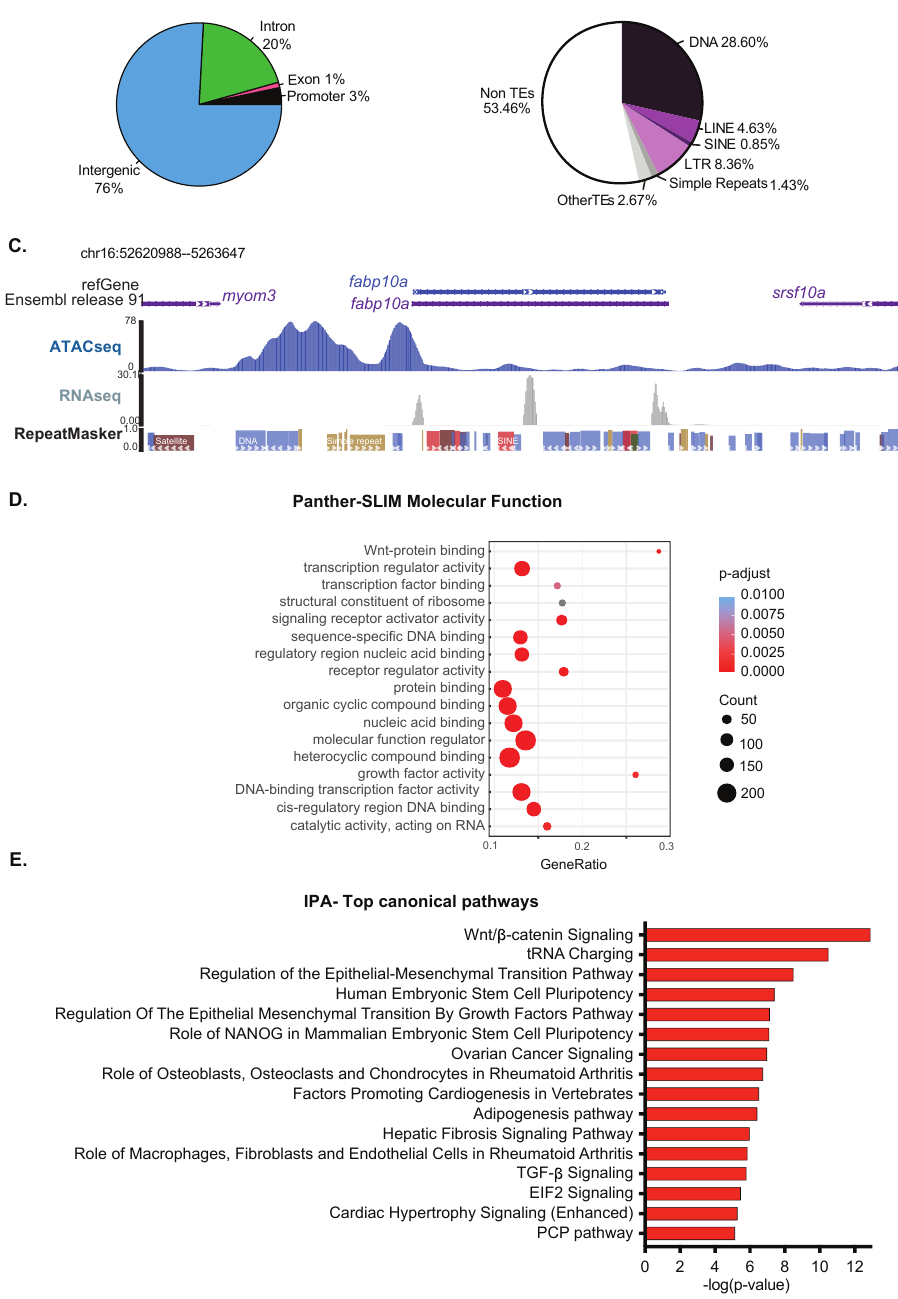
Figure 2. The chromatin landscape in 120 hpf zebrafish livers remains competent for development. ( A ). ATAC-Seq peaks in the 120 hpf zebrafish liver were categorized based on the proportion in distinct genomic elements designated as a promoter (1 kb +/ − TSS), exon, intron, and intergenic. In total, 575 promoters are covered by ATAC-Seq peaks. ( B ). The relative proportion of transposable elements (TEs) across open chromatin region in zebrafish liver at 120 hpf. TE families, including DNA, LINE, SINE, LTR, and simple repeats, are represented with different colors. The other types of REs and non-RE regions are represented as others. ( C ). Browser view of ATAC-Seq and RNA-Seq from 120 hpf livers from the fabp10a gene locus and surrounding regions. Note the DNA transposon located in the center of the ATAC-Seq peak is not expressed in this sample. ( D ). Gene Ontology analysis of the molecular function of genes that either overlap with ATAC-Seq peaks or are the nearest to a peak falling in intergenic regions. The canonical process with annotated genes from open chromatin regions. The top 20 categories from each section were plotted. Dot size in ( D ) represents the number of overlap input genes with the specific geneset. ( E ). IPA analysis of the pathways that are enriched in the same ATAC-Seq positive genes used in ( D